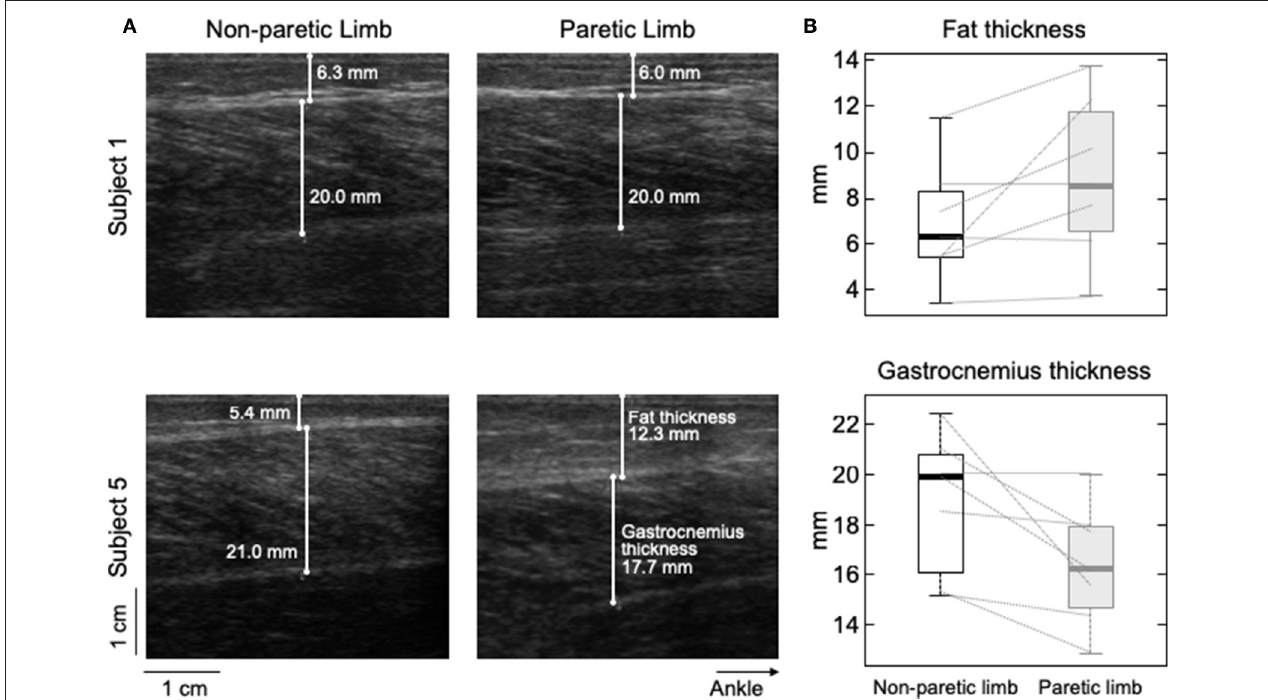
FIGURE 6 | Differences in subcutaneous thickness between limbs. Ultrasound images recorded from the calf of two participants are shown in (A) . Images in the right and left were, respectively, taken from the paretic and non-paretic limb. The white lines superimposed on each image indicate the thickness of fat and MG tissues. (B) shows the distribution of subcutaneous (top) and gastrocnemius (bottom) thicknesses estimated for the seven participants. Thick horizontal lines denote the median values. Boxes and whiskers correspond, respectively, to the interquartile interval and the range